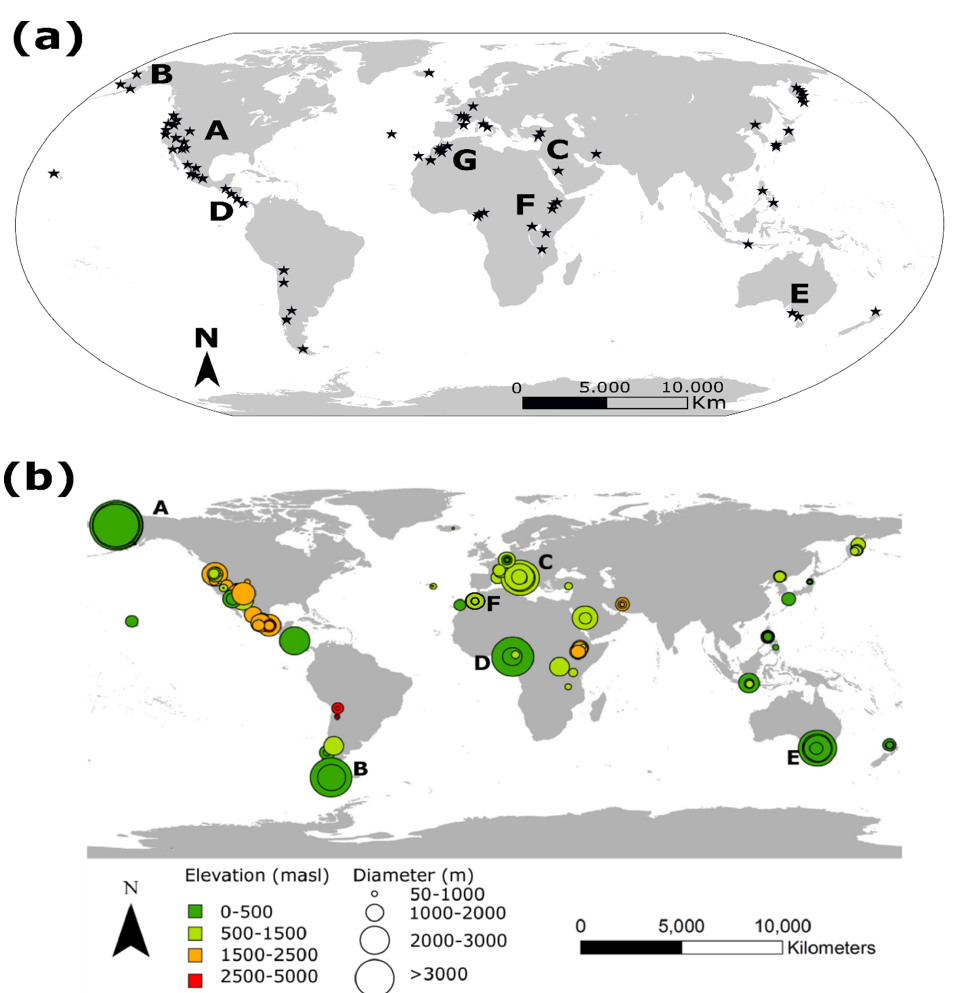
Figure 13. The distribution of maar volcanoes around the world (black stars), we have added the maars of Morocco (modified from [85] ): ( a ) (A) Diamond Crater USA, (B) Espenberg Craters on Seward Peninsula AK-USA, (C) Jabal Simagh of the Harrat Kishb field in Saudi Arabia, (D) Nejapa and Ticomo maars in Nicaragua, Lake Leake of Newer volcanic province-Australia, (F) Hora Lake Bishoftu volcanic field-Ethiopia, (G) Middle Atlas- Anti-Atlas and eastern Meseta field volcanoes Morocco; ( b ) Crater size (average diameter) and elevation plotted geographically with one symbol per maar: (A) Espenberg maars, (B) Pali Aike volcanic field, (C) Colli Albani volcanic region, (D) Kumba volcanic field, (E) Newer volcanic province, (F) Middle Atlas volcanic field.